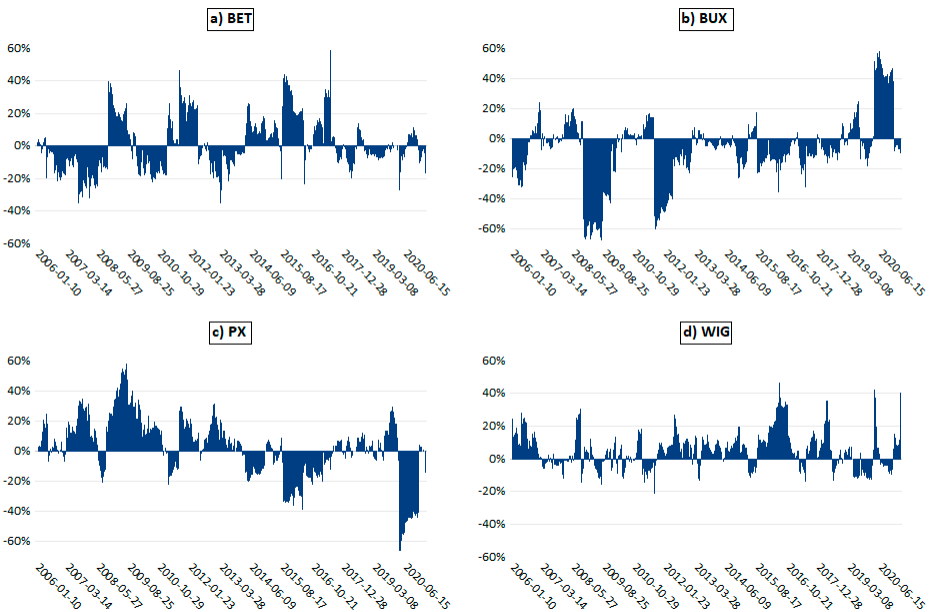
Figure 6. Rolling window estimation of net volatility spillover (the difference between “Contribution to Others” and “Contribution from Others”). ( a – d ) represents the effects of net volatility spillover for the stock market index of Romania(BET), Hungary(BUX),Czech Republic(PX), Po- land(WIG).